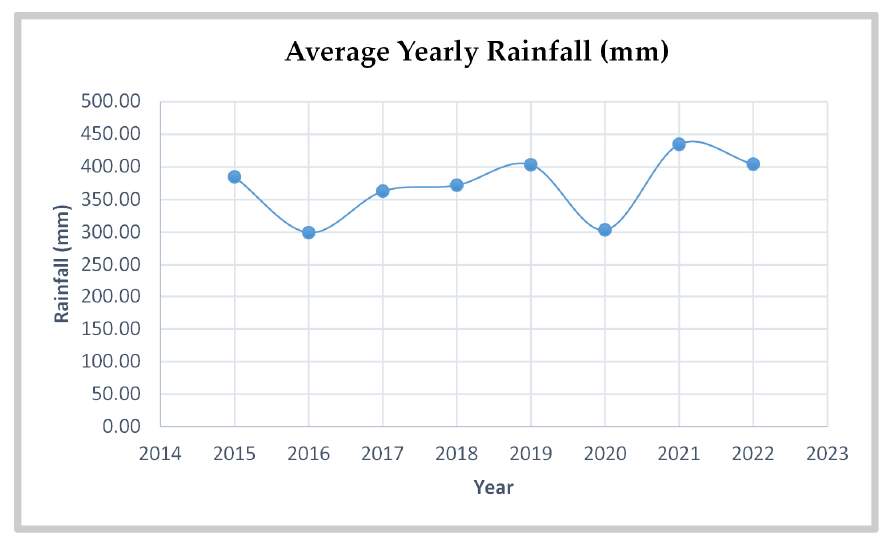
Figure 7. Annual Rainfall Distribution in Neluwa Area from 2015 to 2022. Source: Meteorological Department in Sri Lanka, 2022.